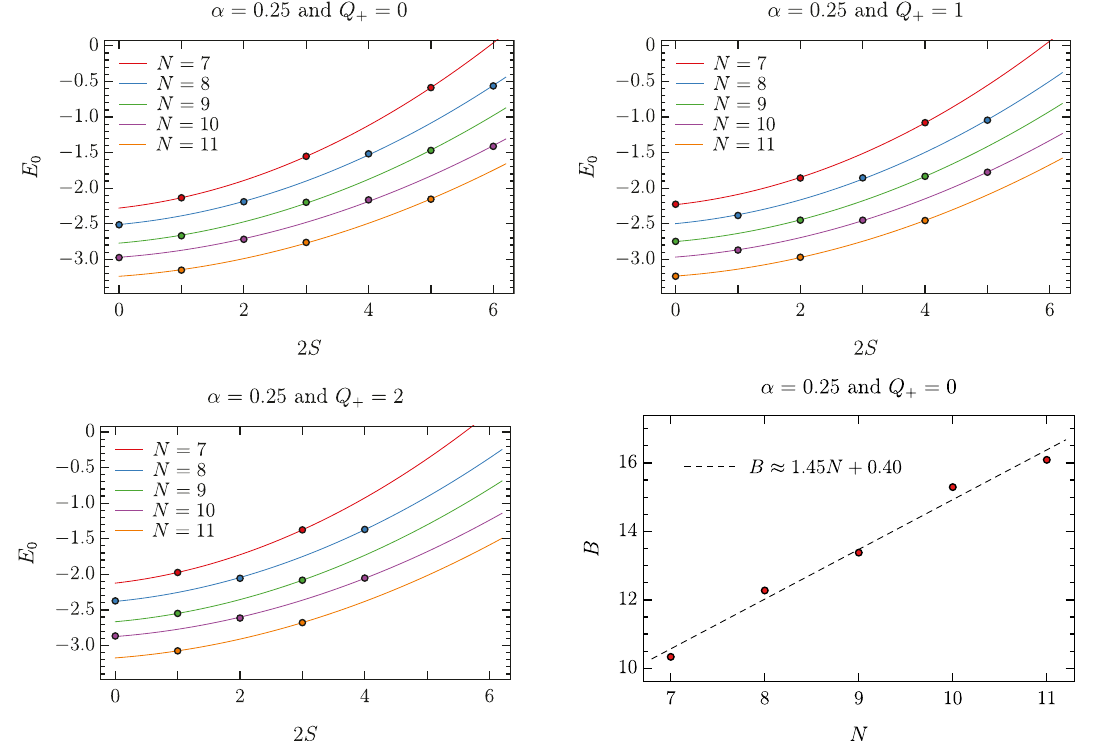
Figure 14 . The dependence of ground state energy at α = 0 . 25 on SU(2) spin S at Q + = 0 , 1 , 2 . We use the Ansatz E 0 ≈ A + 1 compressibility, K